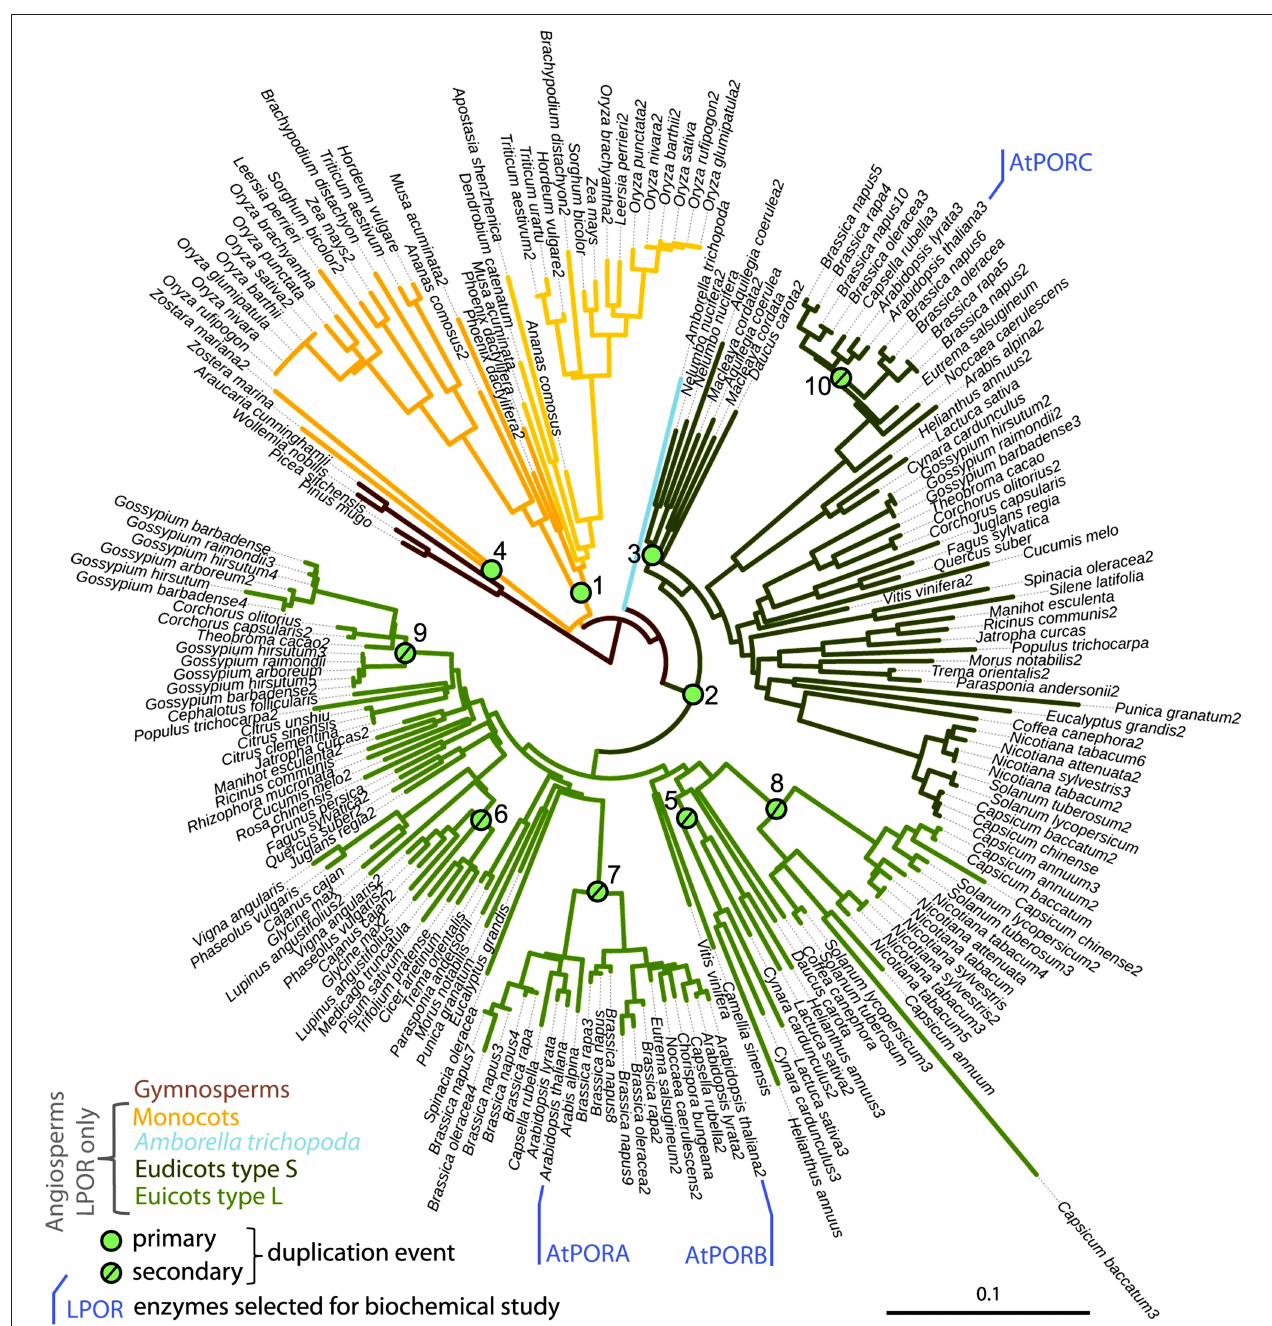
FIGURE 2 | Subtree of LPOR sequences from seed plants, with Arabidopsis thaliana ’s isoforms AtPORA, AtPORB, and AtPORC being marked, and green dots indicating duplication events. Republished with permission of Portland Press Ltd., from The origin, evolution and diversification of multiple isoforms of light-dependent protochlorophyllide oxidoreductase (LPOR): Focus on angiosperms; Gabruk and Mysliwa-Kurdziel (2020), permission conveyed through Copyright Clearance Center, Inc.